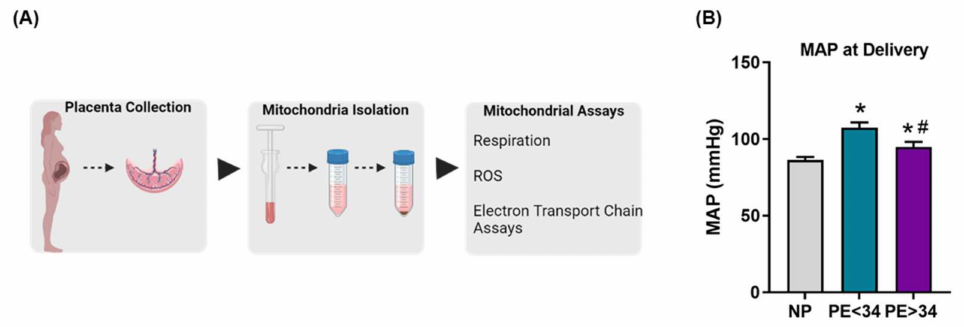
Figure 1. Conceptual figure showing the methodology utilized in the study ( A ), mean arterial pressure (MAP) at the delivery in normal pregnant (NP; gray bar) and preeclamptic patients of early (PE < 34; teal bar) and late gestational ages (PE > 34; purple bar) ( B ). MAP was elevated in both early and late gestational preeclamptic patients (PE < 34 weeks; n = 10 & PE > 34 weeks; n = 13) vs. normal pregnant (NP, n = 30). Further, there was a significant increase in MAP in early gestational patients (PE < 34 weeks) vs. late gestational patients (PE > 34 weeks) ( B ). The results represent means ± SEM. * p < 0.05 vs. NP, # p < 0.05 vs. PE < 34. ROS, reactive oxygen species; SEM, standard error of mean.